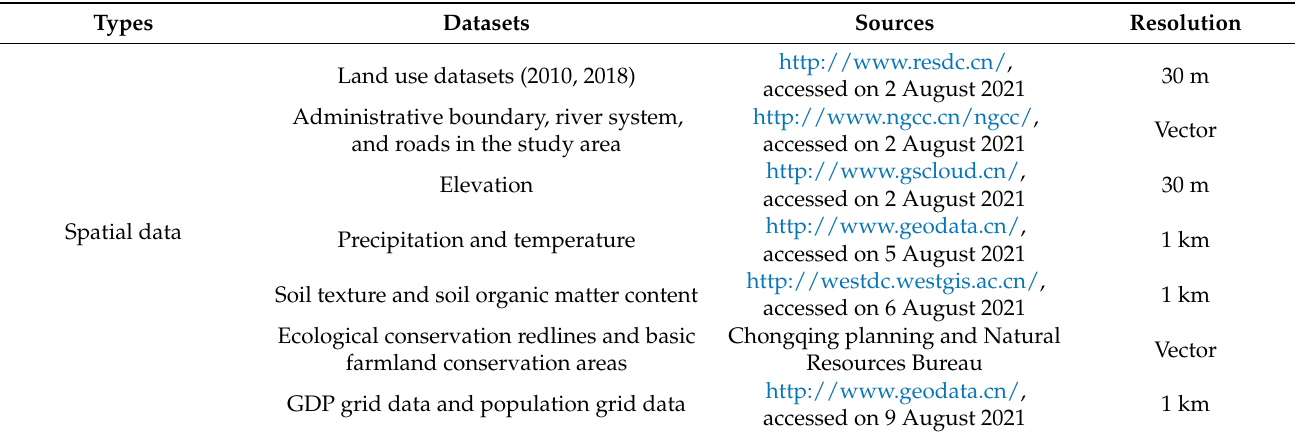
Table 1. Sources of data included in this study.